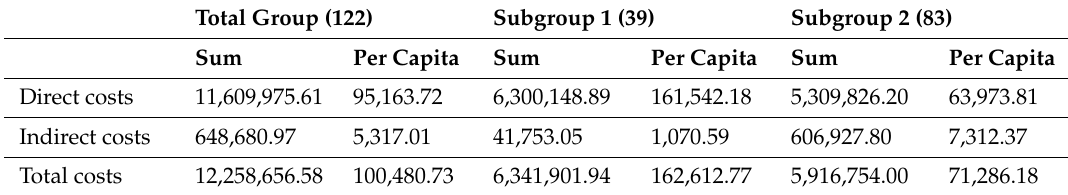
Table 6. Distribution of BW-adjusted direct and total costs / patient / year